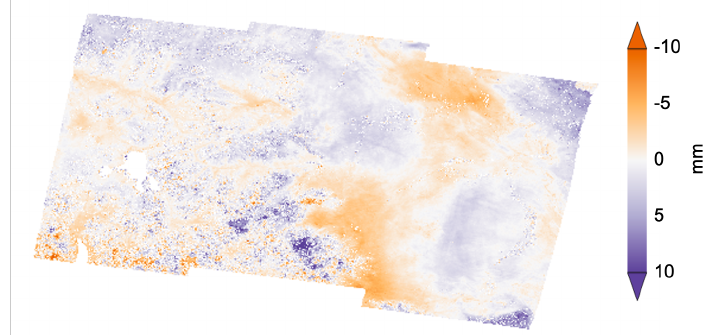
Figure A1. Location of the DInSAR frames and continuously recording GNSS stations. The outline of the Yellowstone national park is shown with magenta.